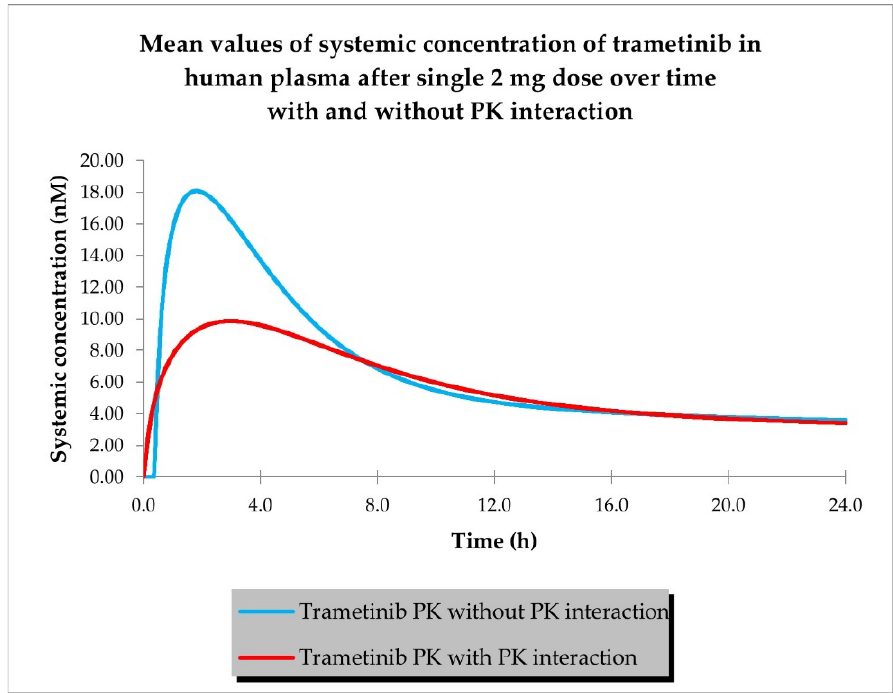
Figure 5. PBPK model of trametinib with and without estimated PK interaction in cancer patient representative ( n = 1).